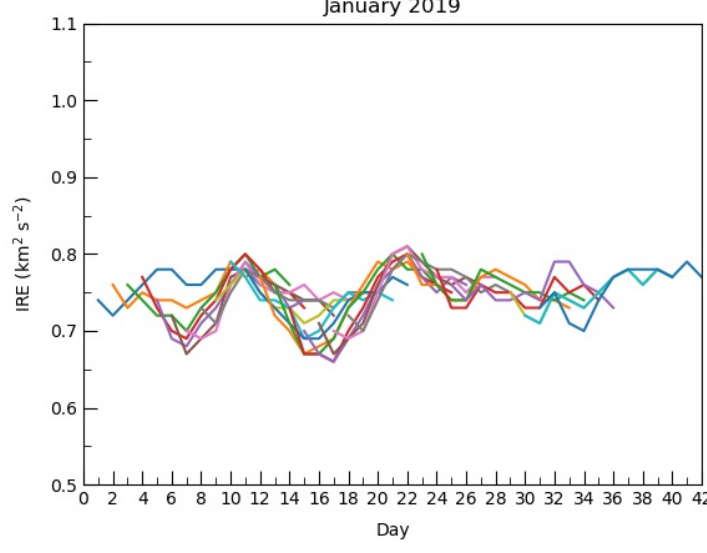
Figure 3. The daily North American Ensemble Forecast System (NAEFS) ensemble mean 10-day forecasts of NH IE for each day in January 2019. Each day (plume) is represented by a different color (e.g., 1 January, 2 January, 3 January, 4 January, 5 January, 6 January, 7 January, 8 January are represented by blue, orange, green, red, purple, brown, lavender, light blue, respectively) until 9 January when the color scheme repeats.